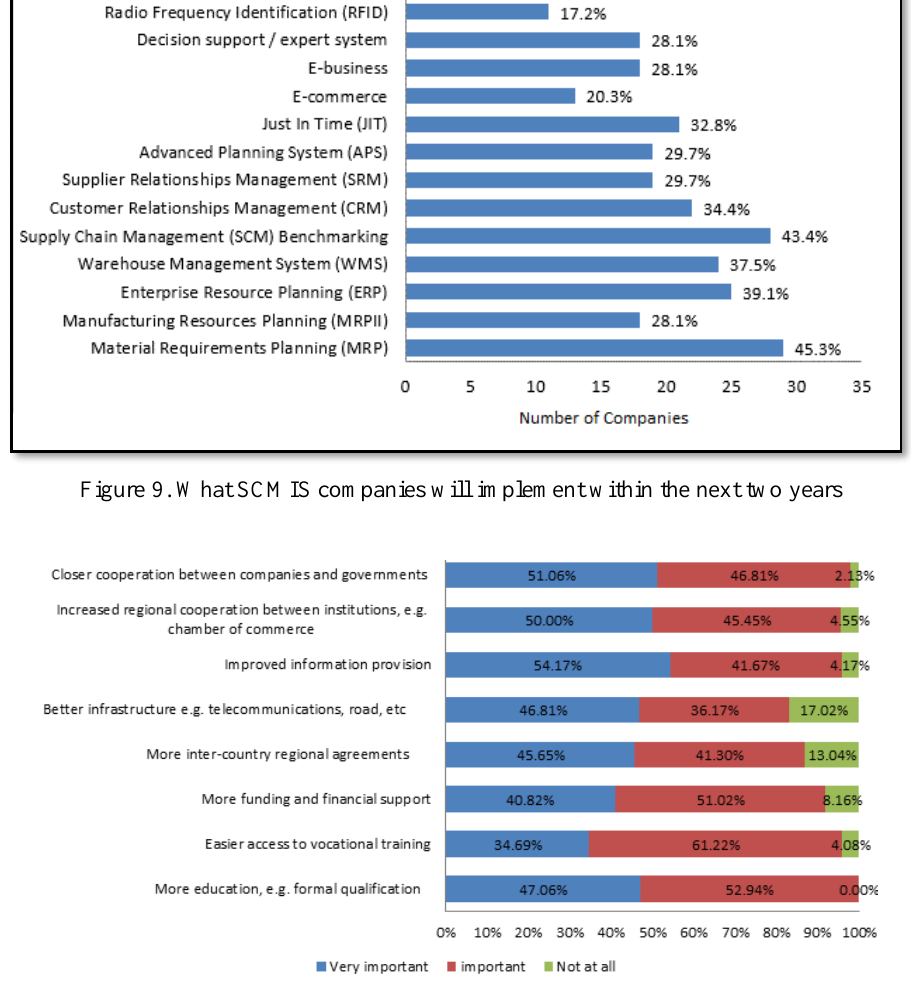
Figure 10. Strategies to improve the future of